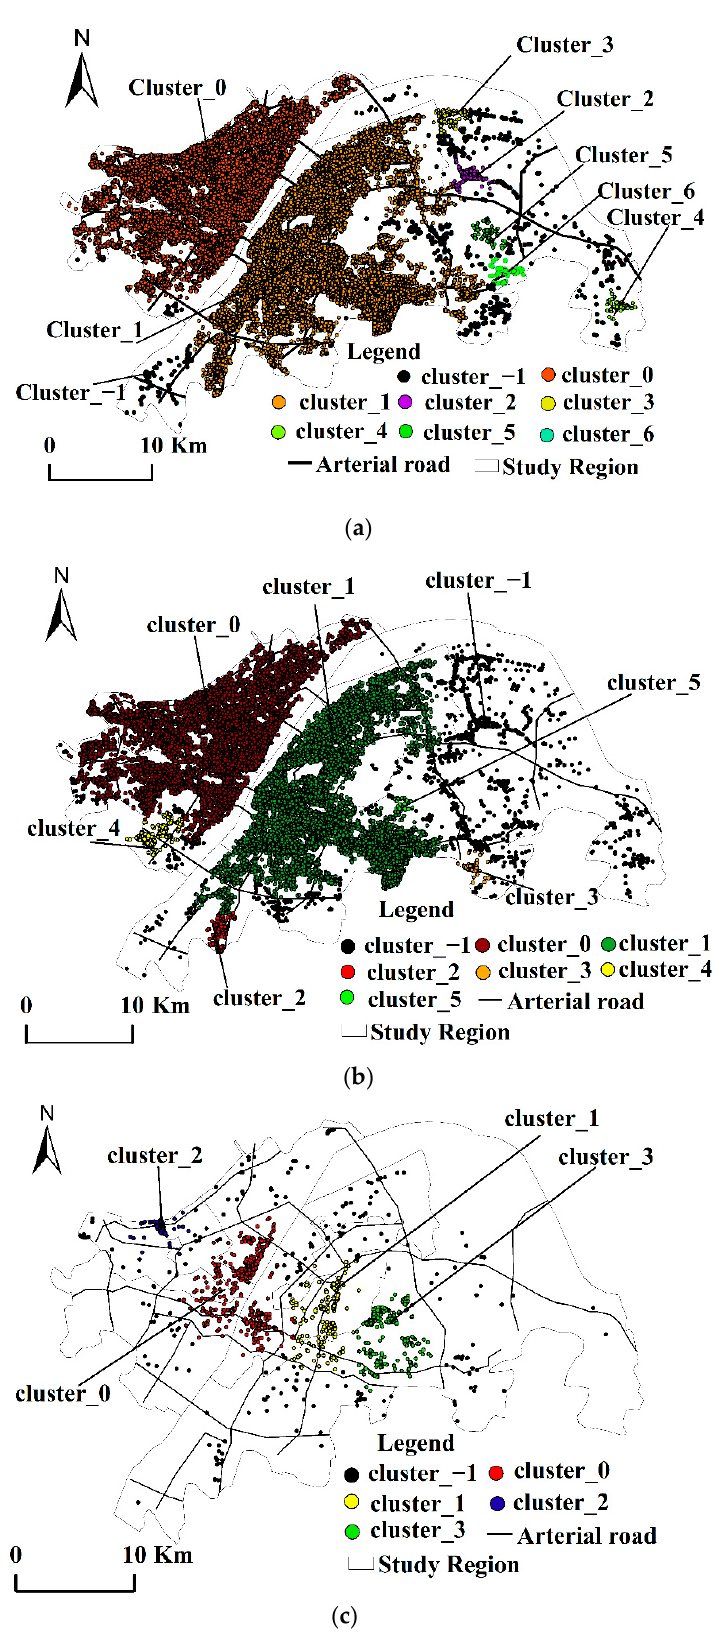
Figure 4. “Production–living–ecological” clustering spatial distribution pattern. ( a ) “Living” clus ‐ tering spatial distribution pattern. ( b ) “Production” clustering spatial distribution pattern. ( c ) “Eco ‐ logical” clustering spatial distribution pattern.